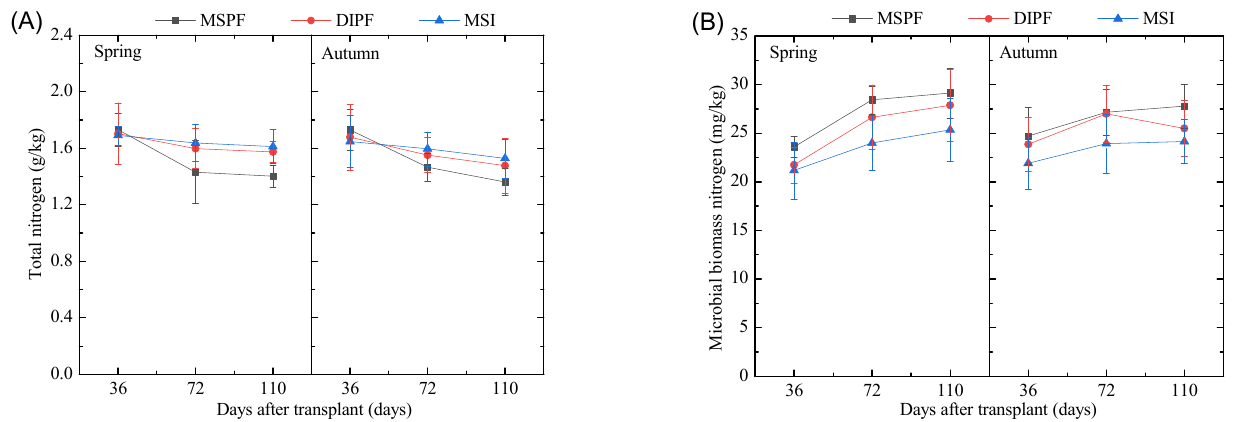
Figure 4. Response of soil total nitrogen ( A ) and soil microbial biomass nitrogen ( B ) to irrigation strategy and plastic film mulching during spring and autumn season.